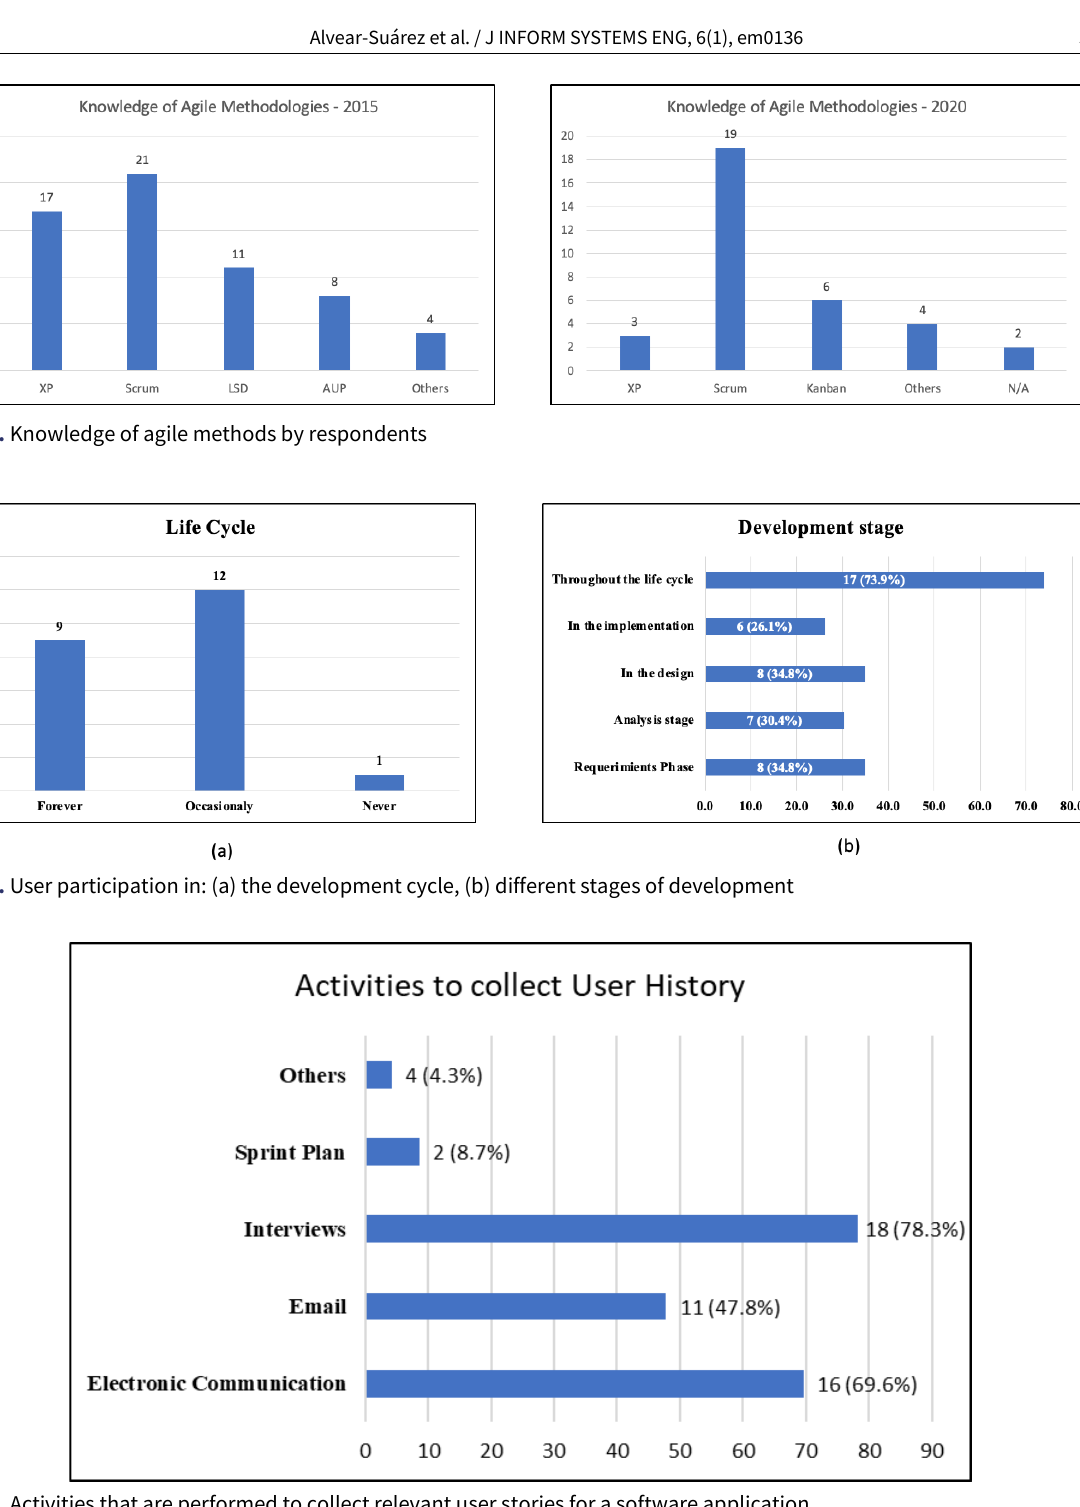
Figure 5. Activities that are performed to collect relevant user stories for a software